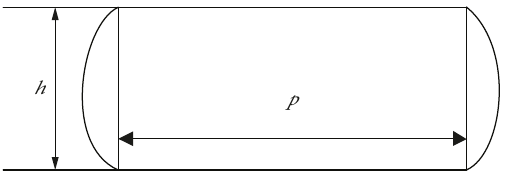
Figure 9: Cross section of the wire at fi